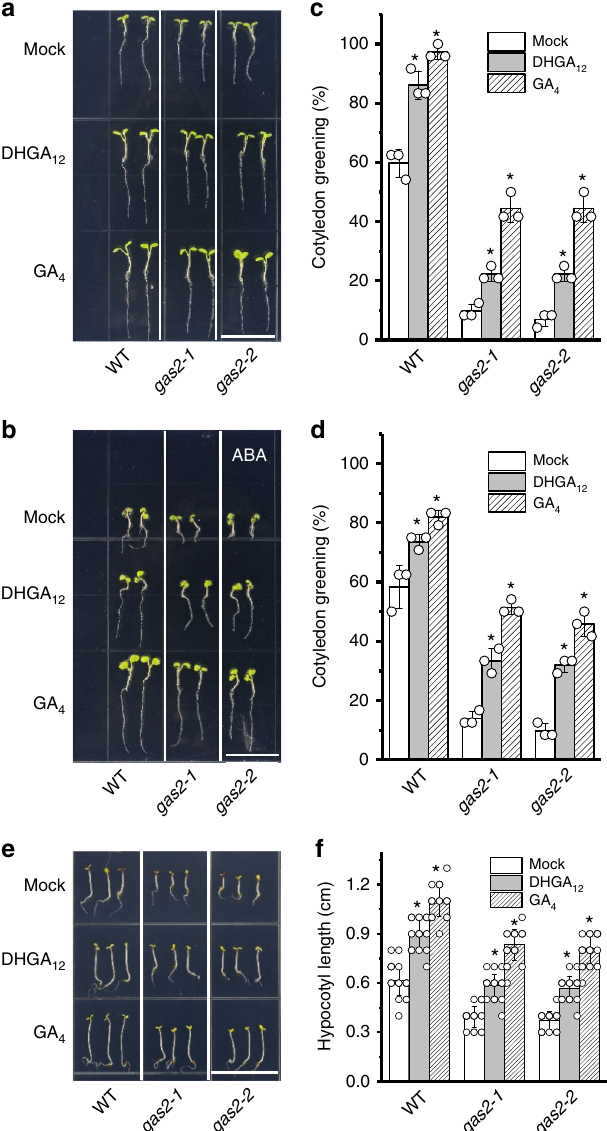
Fig. 5 DHGA 12 antagonistically suppresses the effect of ABA in seedling establishment. a , b Effects of exogenous application of DHGA 12 and GA 4 on cotyledon greening of wild-type, gas2-1 , and gas2-2 , germinated 10-d on MS and MS + 0.2 µ M ABA, with or without the addition of DHGA 12 or GA 4 . Bars = 1.5 cm. c , d Cotyledon greening analysis of wild-type, gas2-1 , and gas2-1 , grown on MS at day 4 ( c ) and MS + 0.2 µ M ABA at day 7 ( d ), with or without the addition of DHGA 12 or GA 4 . Error bars represent SD ( n = 72, t test, * P < 0.05). Values are the mean of three independent experiments. e , f Effects of exogenous application of DHGA 12 and GA 4 on hypocotyl elongation of 5-d wild-type, gas2-1 and gas2-2 seedlings grown under continuous far-red light illumination. Data represent means ± SD ( n = 22, t test, * P < 0.05). Source data are provided as a Source Data fi le.